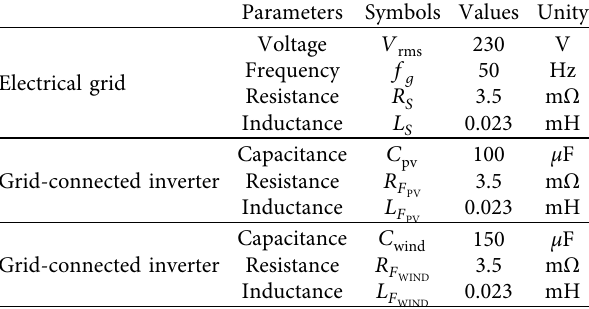
Table 1: Grid and grid-connected inverter